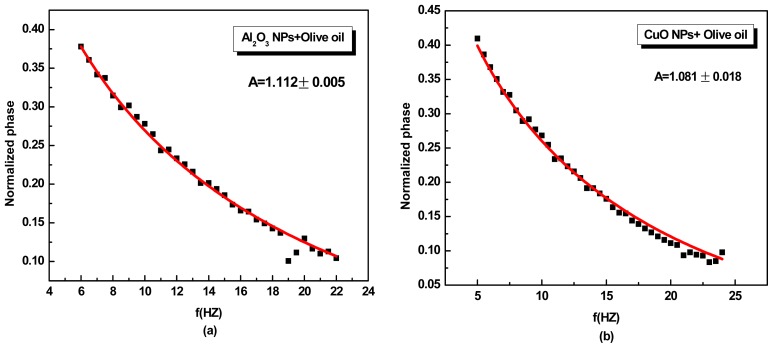
The pyroelectric (PE) normalized phase of Al2O3 + olive oil (a) and CuO + olive oil; (b) as a function of the light modulation frequency. Dots are experimental data and the solid line is the best fit to Equation 1.